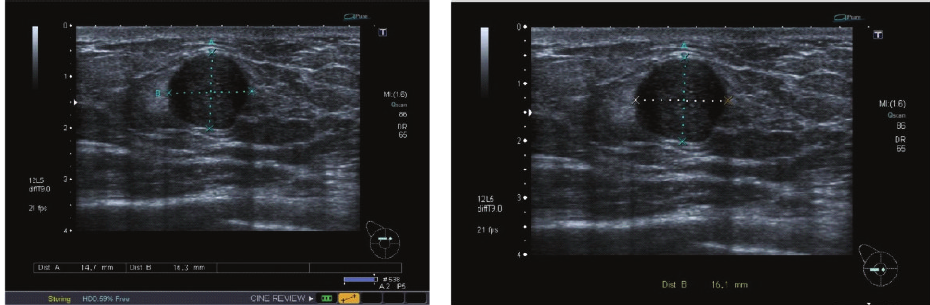
Figure 1: Ultrasound scan showing the lesion 15 × 16mm mass (U3).